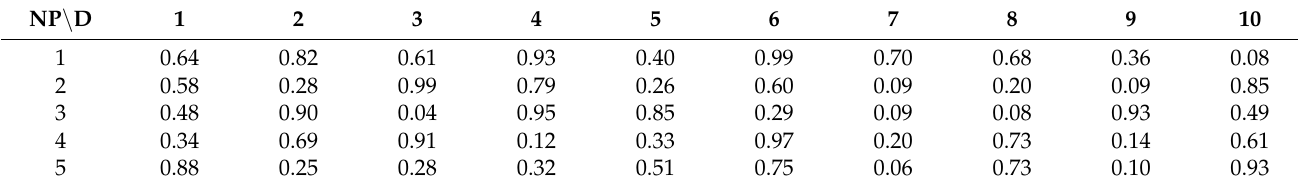
Table 3. Initial WP when D = 10 and i = 5.